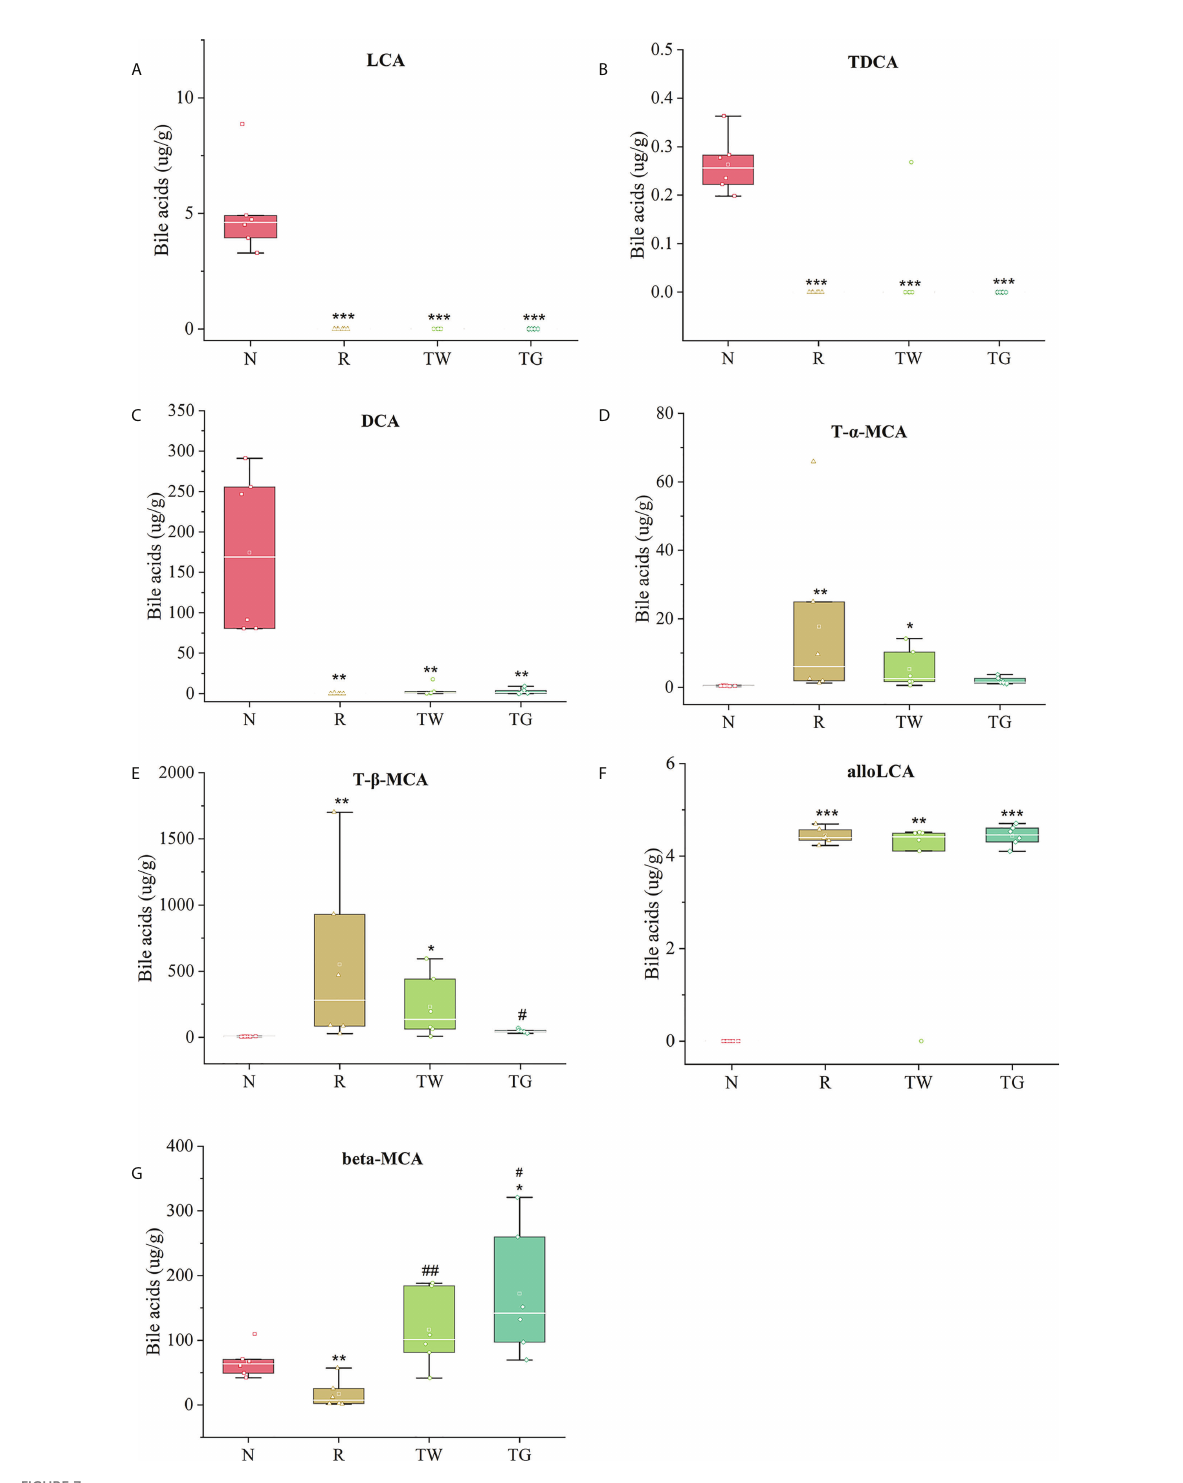
FIGURE 7 Contents of biomarker candidates of bile acid. * P < 0.05, ** P < 0.01, and *** P < 0.001 compared with the N group; # P < 0.05 and ## P < 0.01 compared with the R group. N, normal control group; R, antibiotic-associated diarrhea (AAD) restore group; TW, Qiwei Baizhu Powder (QWBZP) decoction group; TG, total glycosides of Qiwei Baizhu Powder (QWBZP-TG)